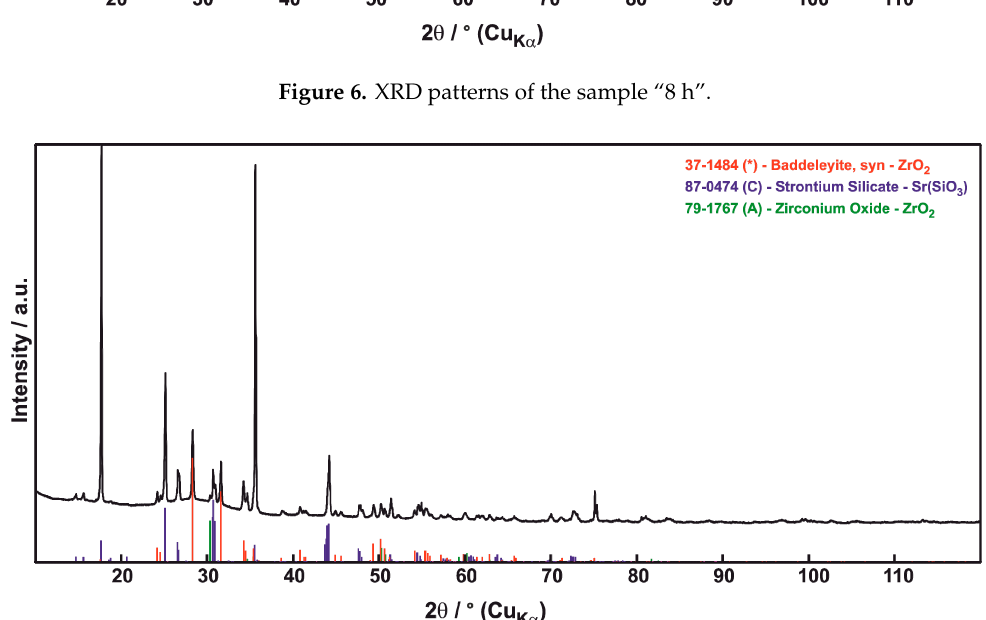
Figure 7. XRD patterns of the sample “10 h”.